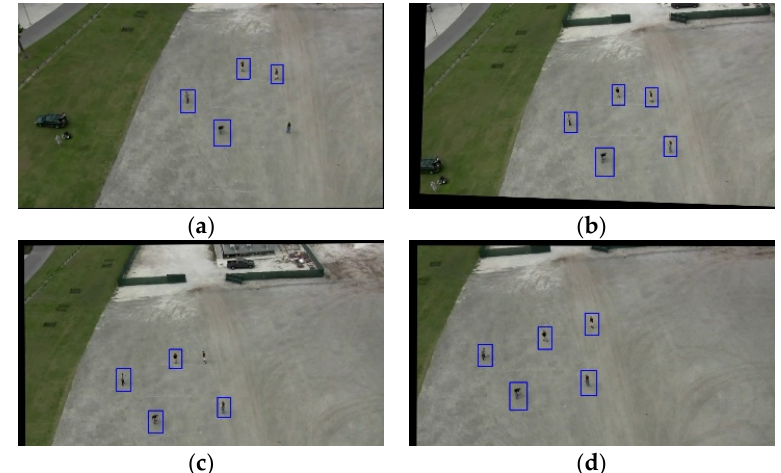
Figure 11. The result of moving object detection in Action2: ( a ) Frame 25, ( b ) frame 100, ( c ) frame 170, ( d ) frame 440.